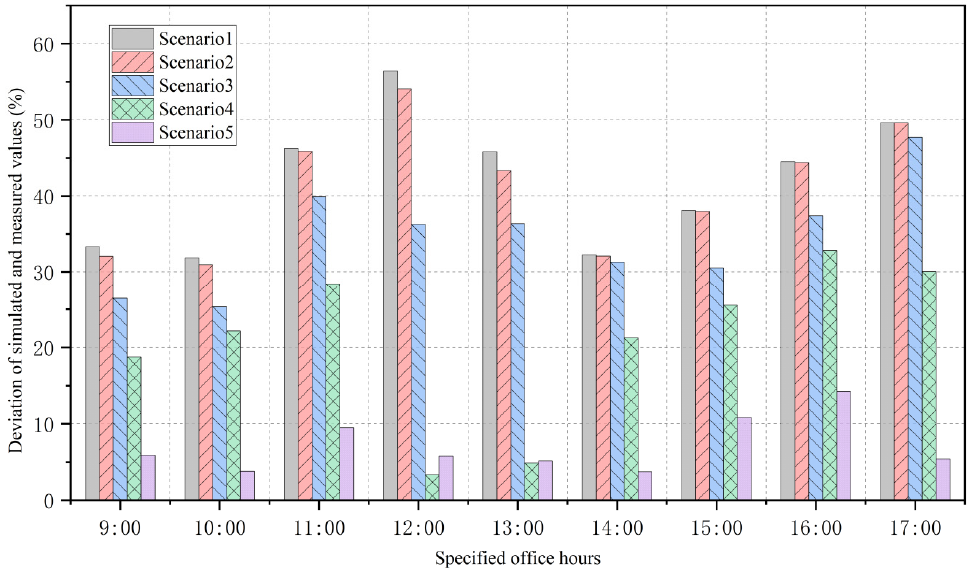
Figure 25. Deviations between simulated and measured variable energy consumption under different scenarios. Table 11. Comparison of variable energy consumption prediction effects under different scenarios.